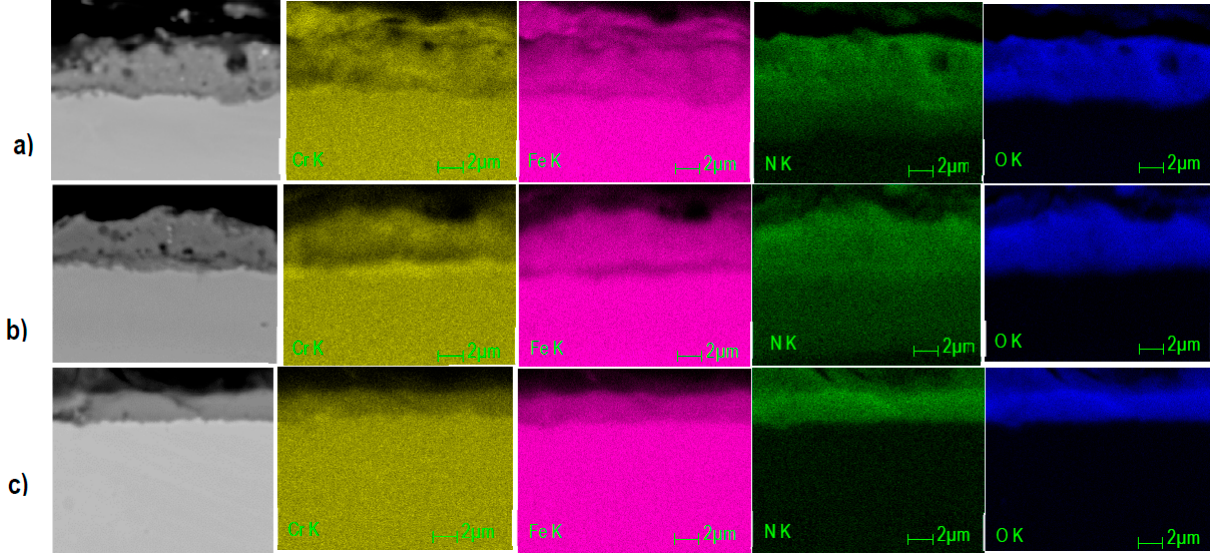
Figure 8. Chemical mapping by SEM-EDS on oxy-nitrided AISI 304 SS with: ( a ) 20 wt% urea, ( b ) 30 wt% urea and ( c ) 40 wt% urea. Table 2. Molecular percentages of iron species present on AISI 304 SS surfaces treated with each urea concentration.